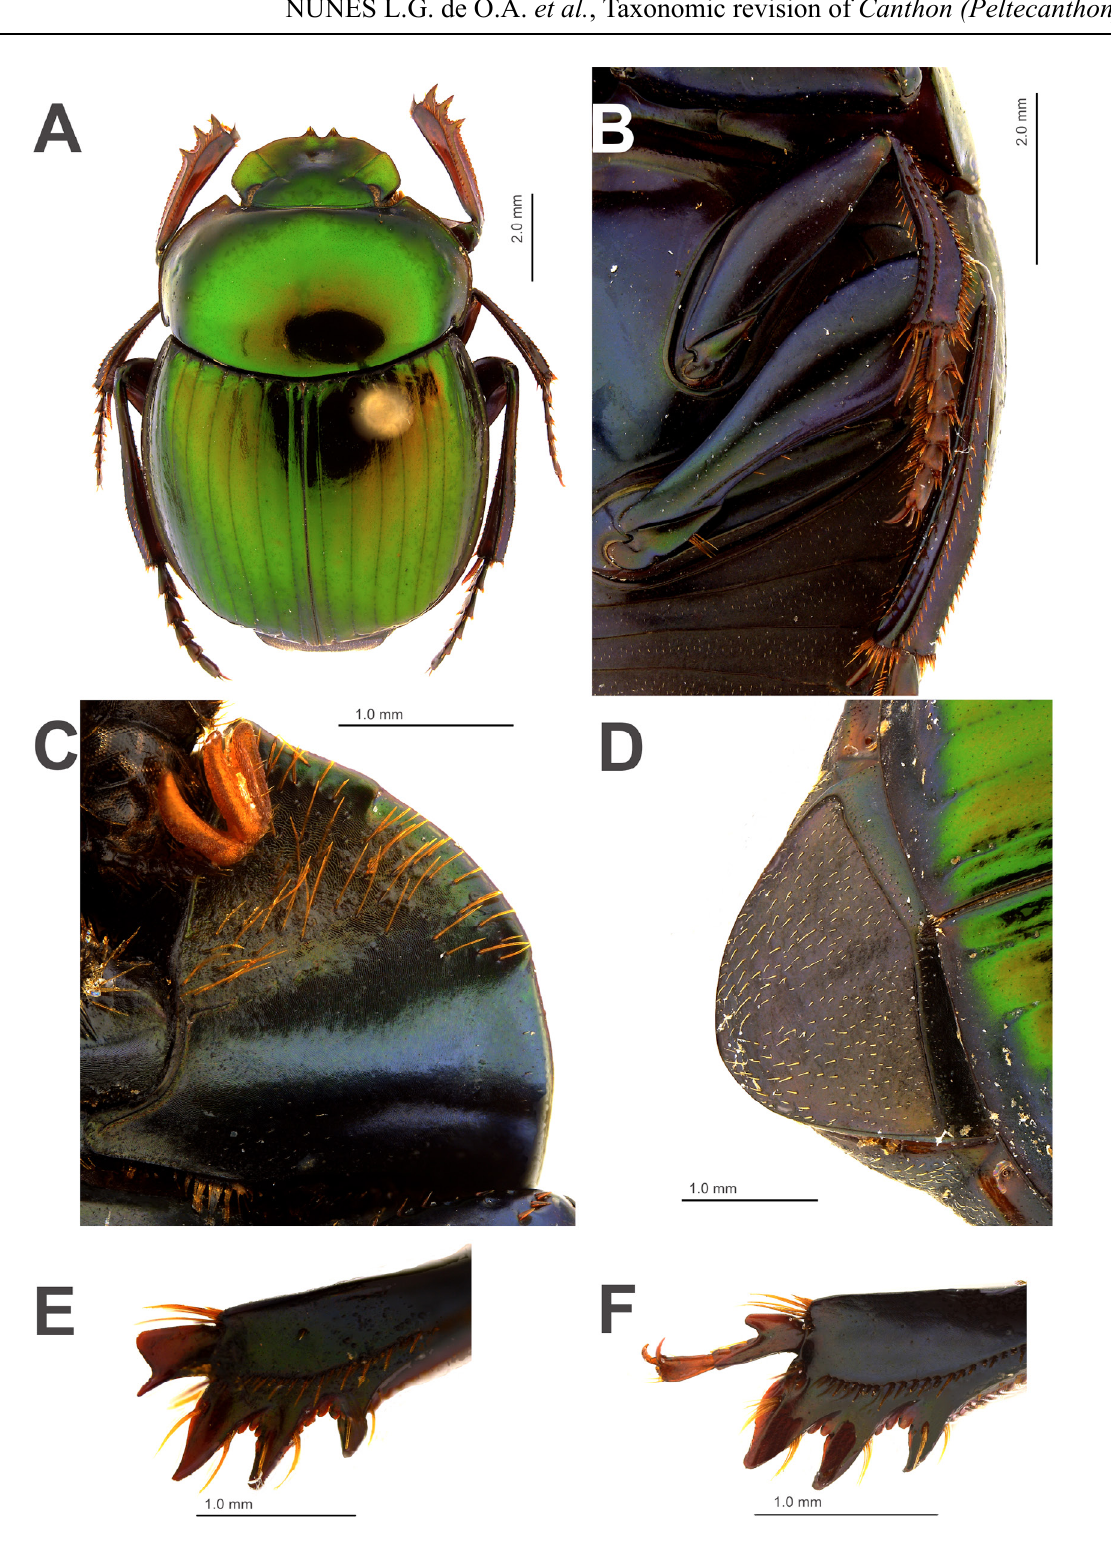
Fig. 3. Canthon ( Peltecanthon ) haroldi Harold, 1867 nom. nov. A–E . Male, Porto Seguro, RPPN Veracel (CEMT). A . Dorsal habitus. B . Ventral surface of meso- and metafemora. C . Hypomeron without transverse carina. D . Margin between pygidium and propygidium without central carina. E . Male protibial spur. F . Female protibial spur, Marliéria, P.E. do Rio Doce